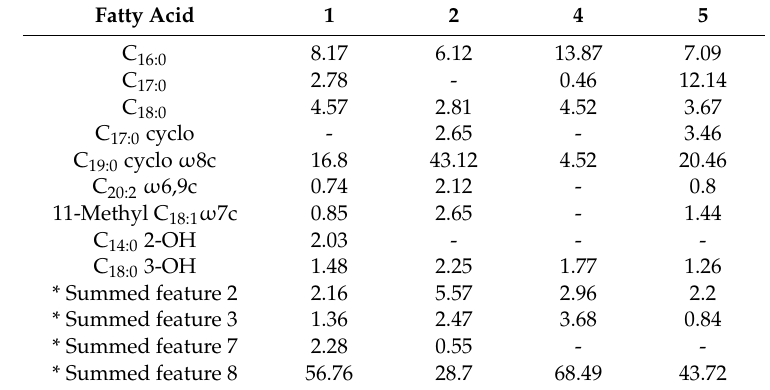
Table 2. Fatty acid composition of strain HR1 and closely related species and type species of the genus Microvirga. (Strains: 1. M. thermotolerans HR1 (data from this study); 2. M. flavescens c27j1 (data from this study); 3. M. indica S-MI1b (data from this study); 4. M. subterranean FaiI4 (data from this study); * Summed features are groups of two or three fatty acids, which cannot be separated using the MIDI system. Summed feature 2 contains C 12:0 aldehyde and / or unknown ECL 10.9525; summed feature 3 contains C 16:1 ω 7c / C 16:1 ω 6c and / or C 16:1 ω 6c / C 16:1 ω 7c; summed feature 7 contains C 19:1 ω 7c / C